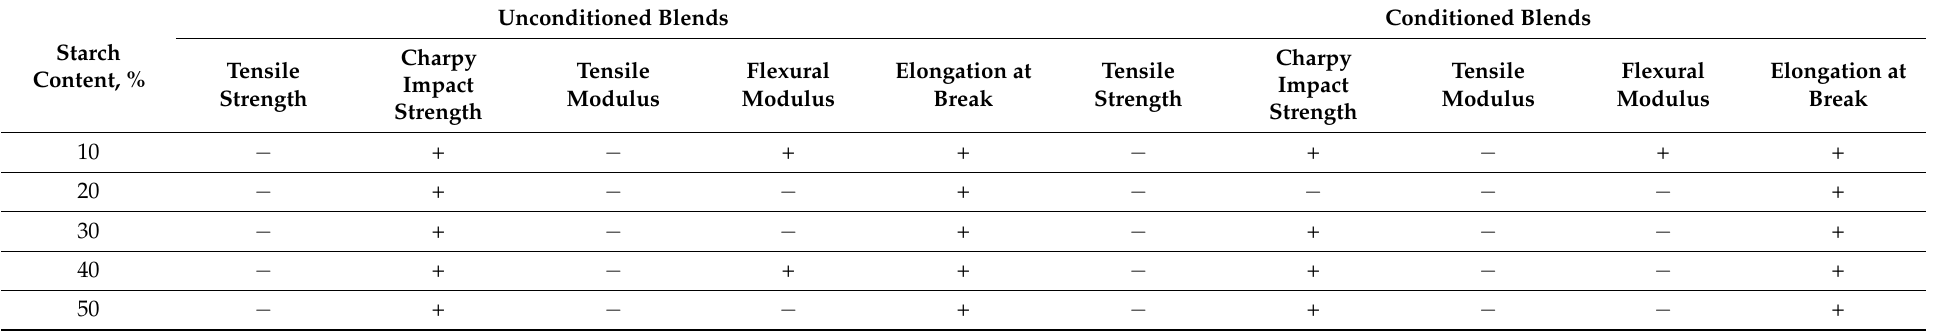
Table 4. Effects on mechanical properties of rapeseed oil-based additive (“+”: positive change relative to an additive-free blend of a suitable composition; “ − ”: negative change relative to an additive-free blend of a suitable